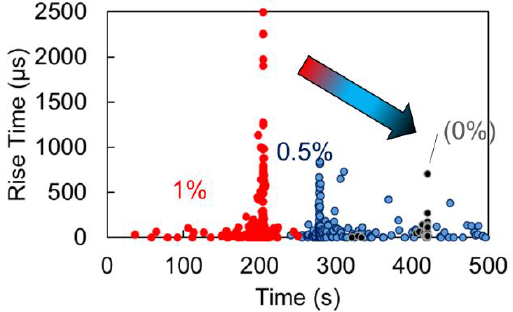
Figure 5. Cumulative AE curves for typical concrete specimens with different vol.% of steel fibers tested on three-point bending.